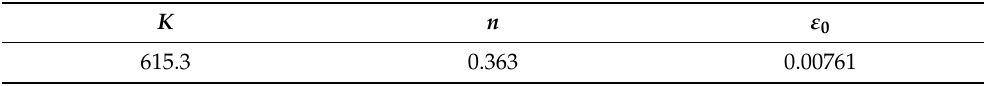
Table 5. Swift constitutive equation coefficients of material